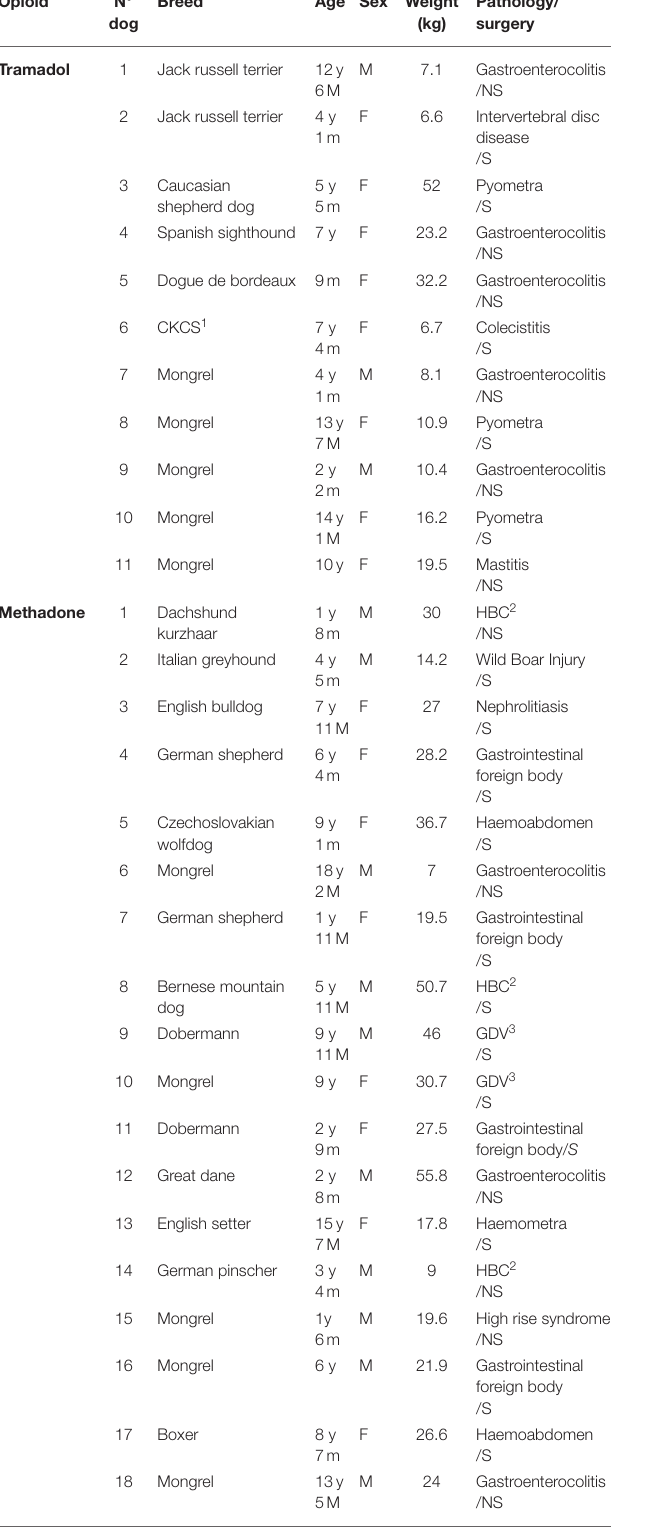
TABLE 1 | Dogs enrolled in Groups 1, 2 and 3 dogs. Opioid N ◦